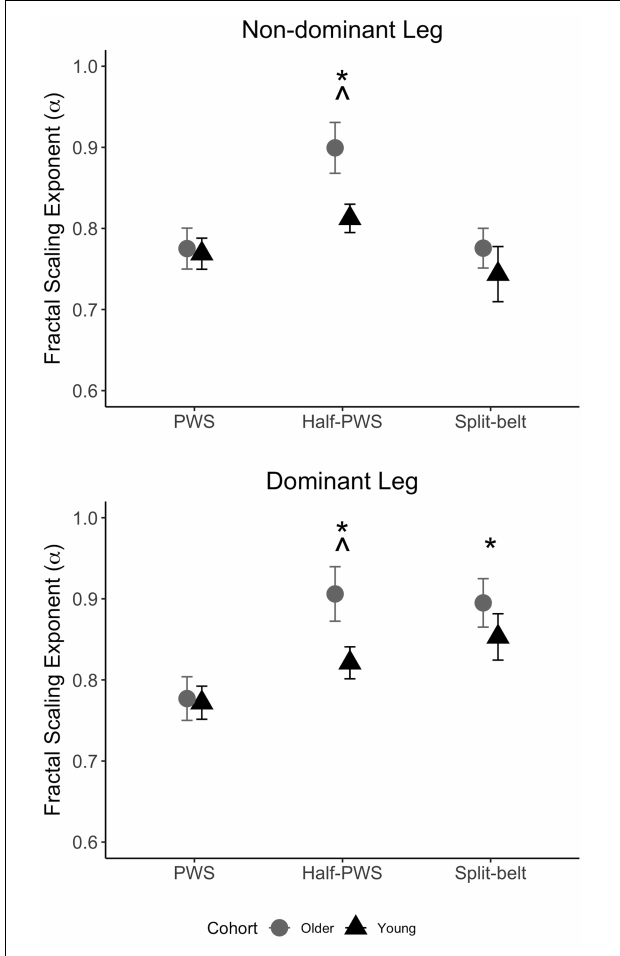
FIGURE 1 | Fractal scaling across conditions for the non-dominant (top) and dominant (bottom) limbs in young (black triangles) and older (gray circles) adults. Data are mean ± SEM. P < 0.05: ∗ indicates > PWS; ∧ indicates condition (PWS, half-PWS) by cohort interaction.